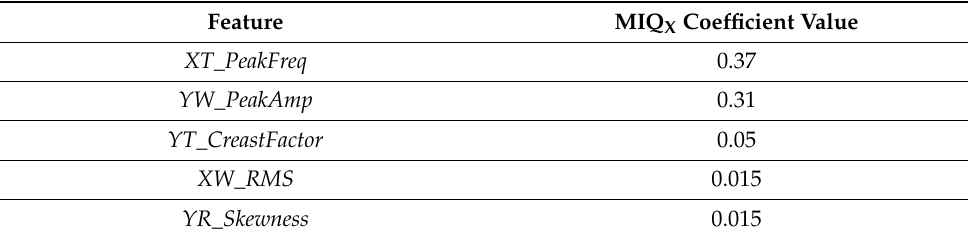
Table 2. Fundamental features of vibration